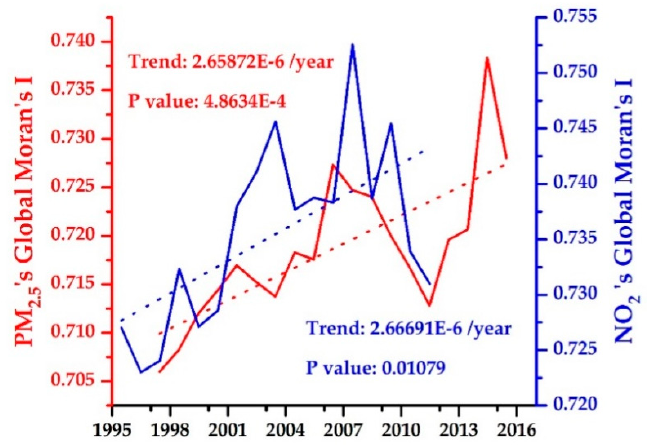
Figure 6. Global Moran’s I variations of the near-surface PM 2.5 (1998–2016) and NO 2 (1996–2012) concentrations over the